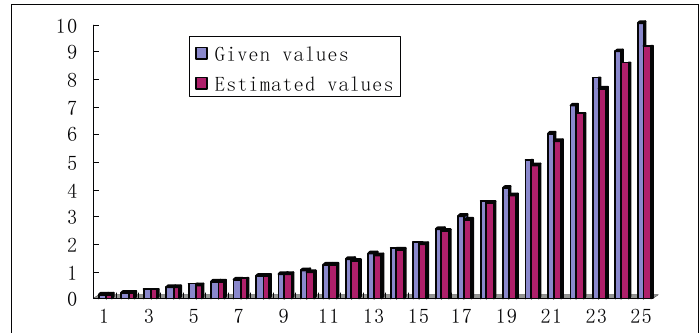
Figure 7. The noise variance estimation versus the given